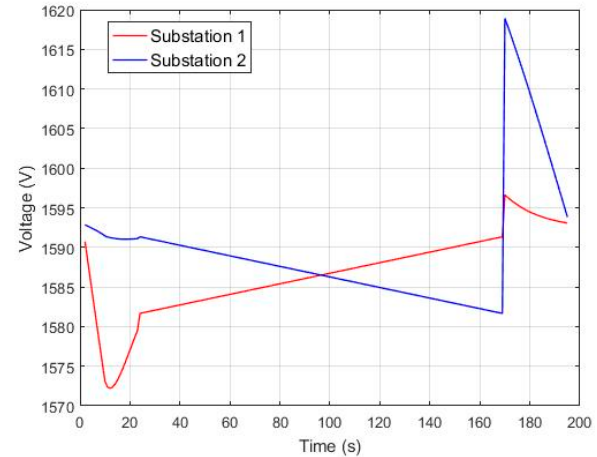
Figure 11. Traction network voltage of two traction substations [38].